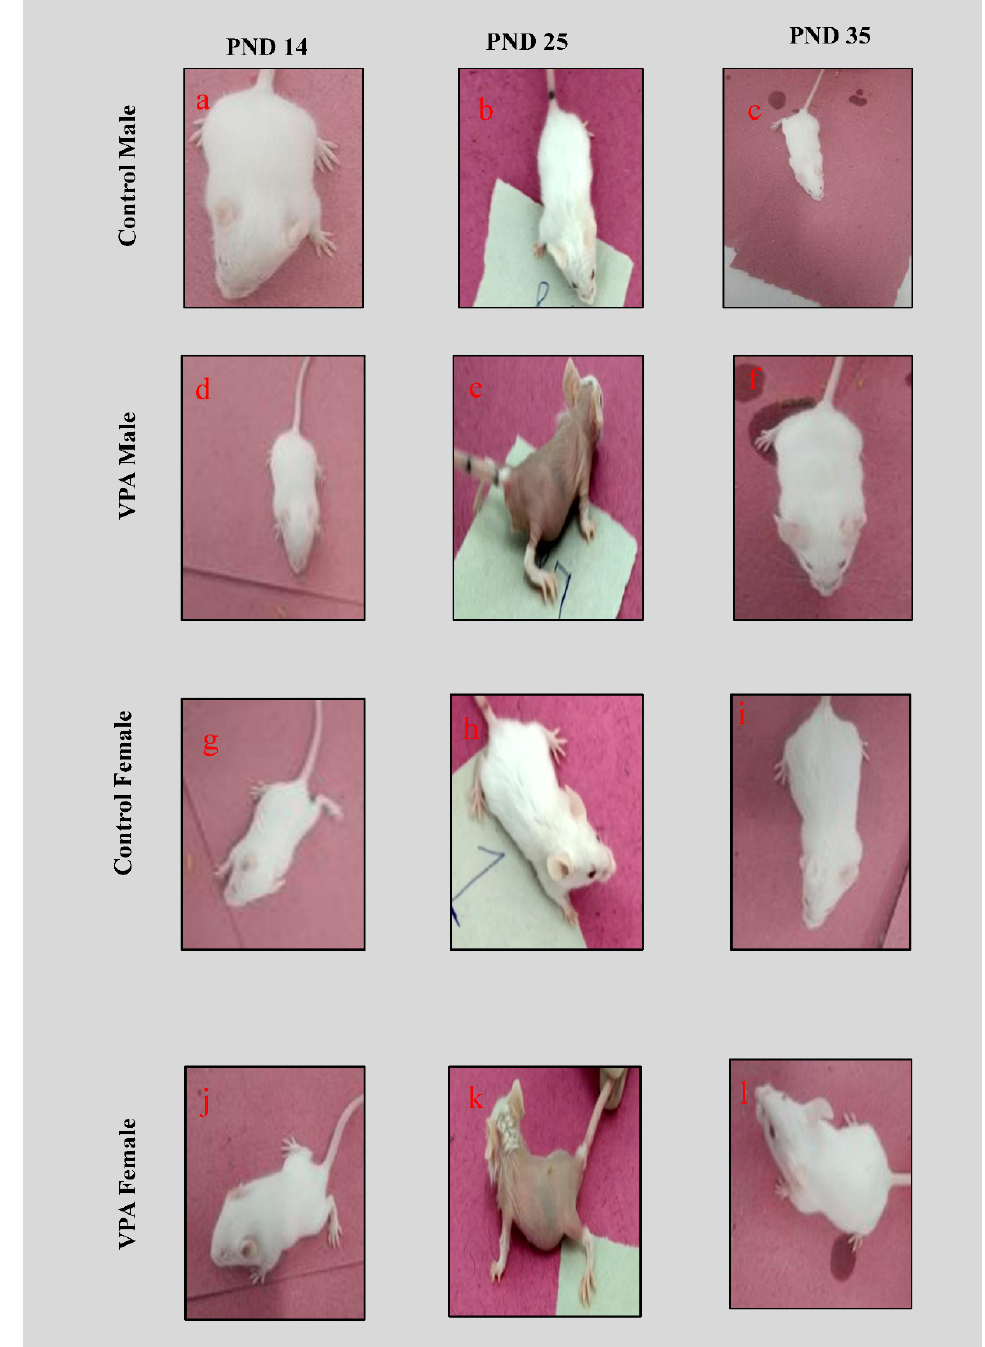
Figure 2. Representative hair coating images from each batch of mice ( a – l ) at different age groups (PND 14, 25, 35). Normal hair coating in ( a – c ) control male and ( g – i ) female. Alopecia was observed in € VPA male and ( k ) female animals.